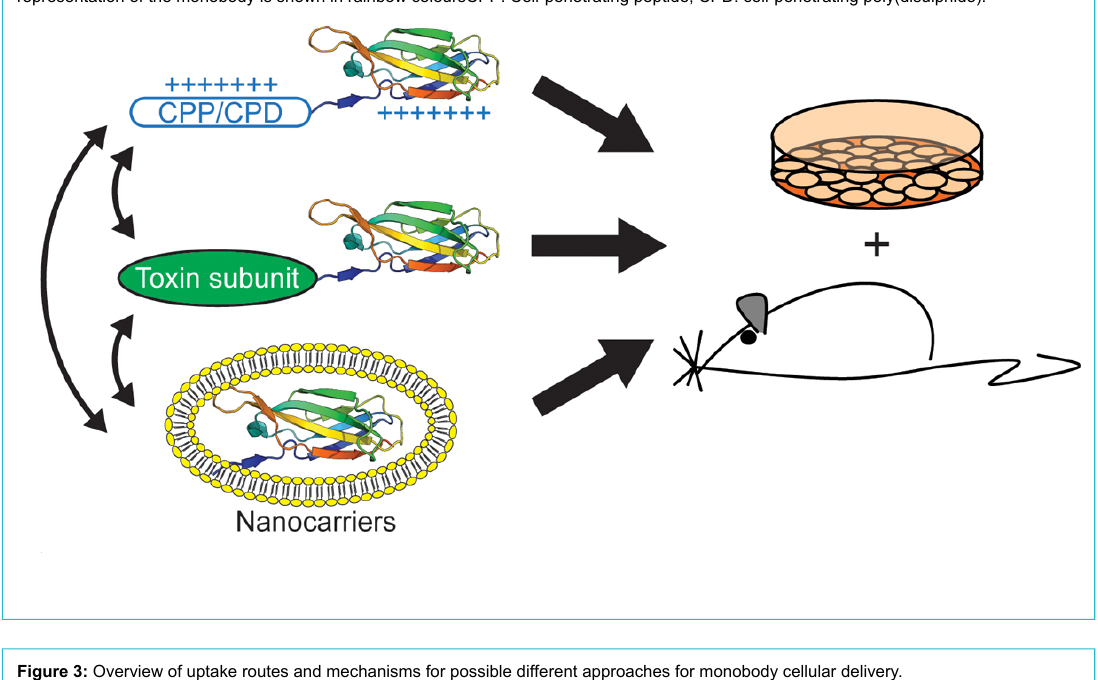
Figure 2: Overview of the three main intracellular delivery strategies for monobodies that are discussed in this review. A cartoon structural representation of the monobody is shown in rainbow coloursCPP: Cell-penetrating peptide, CPD: cell-penetrating poly(disulphide).